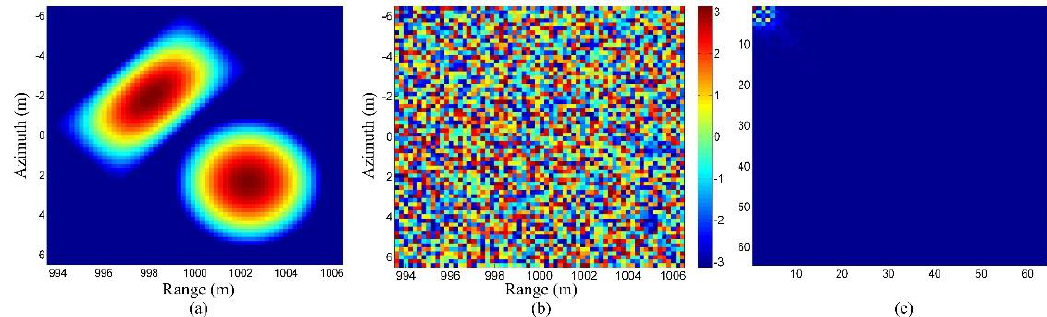
Sensors 2019 , 19 , x 11 of 19 Figure 9. ( a ) Conventional CS reconstruction result (reconstruction time = 44,032 s). ( b ) Segmented reconstruction result (reconstruction time = 1498 s) (taken from [71]). Structured dictionaries and dictionary learning ideas are proposed in [75] and [76], respectively. An alternative approach is to handle the magnitude and phase separately [41]. Although the phase of the scene is potentially random, the magnitude of the scene usually has better sparse characteristics. However, this approach has a much higher computational complexity than standard CS reconstruction. Another method investigates physical scattering behavior [4,77]. For example, a car can be represented as the superposition of responses from plate and dihedral shapes. Figure 10 shows a simulation example for an extended and complex-valued scene. There are two extended objects in the scene, one of which has a round shape while the other has a rectangular shape. Both the two objects have random phases associated with them. It can be seen that the DCT (Discrete Cosine Transform) results of the magnitude are sparse. Figure 11a shows the result of matched filtering. Since the random phase leads to speckle, it can be seen that although the scene has a smooth shape, the matched filtering result has obvious fluctuation. Figure 11b shows the result of conventional CS reconstruction without sparse representation. The reconstruction algorithm is SPGL1 [78]. Since the scene is not sparse in the canonical basis, the reconstruction is not accurate. Figure 11c shows the result of the method using a